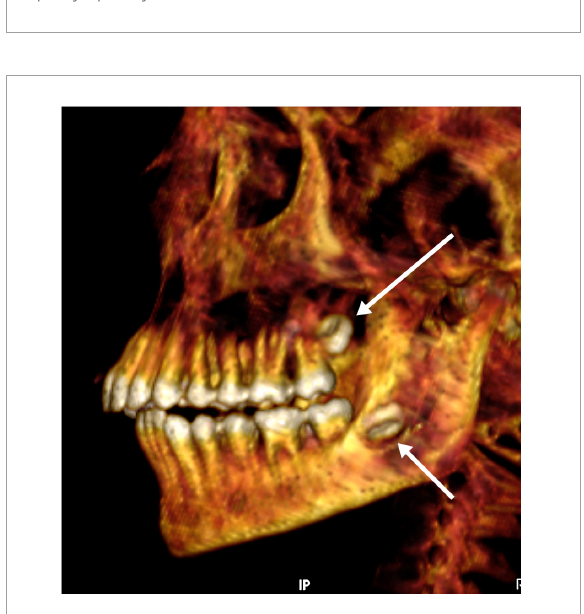
FIGURE6 Three-dimensional computed tomography (CT) image in frontal view of the face of mummy TR 21/11/16 at the Cairo Egyptian Museum. An oval face, with a small nose, a narrow chin, and partly open eyes.